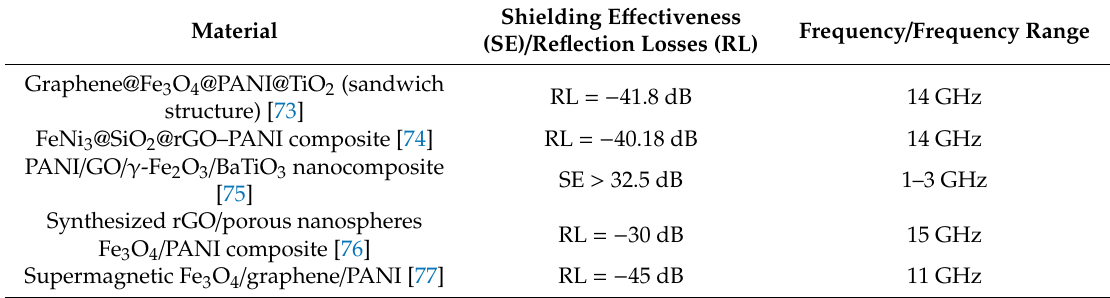
Table 7. Shielding e ff ectiveness or reflection losses of polymer-based